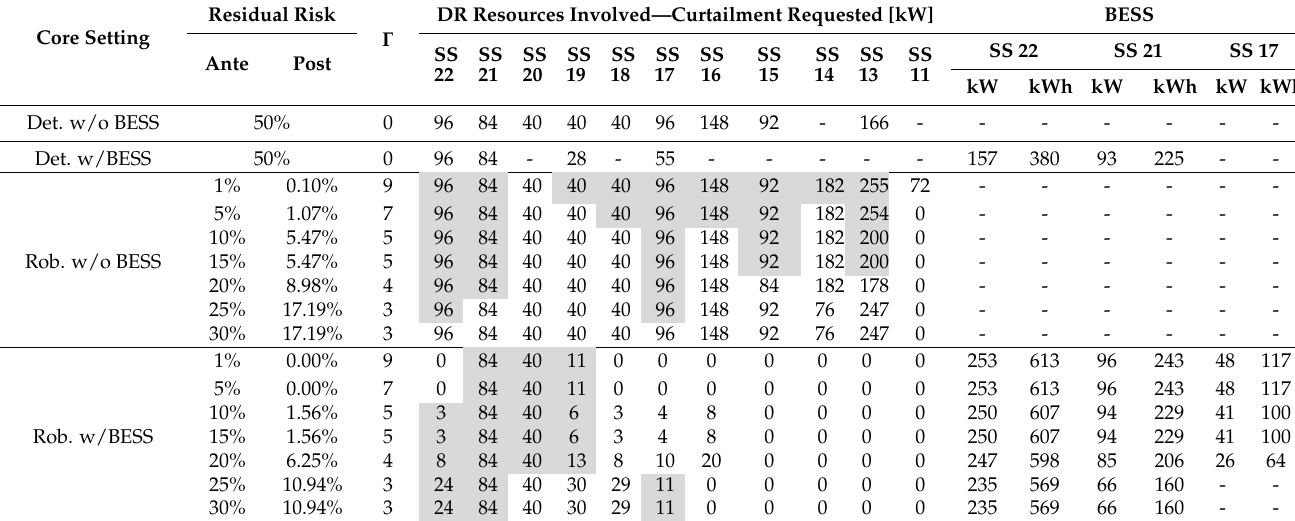
Table 5. Detailed results of the four core-settings for the single hour contingency (19th). The values of Γ are calculated for the technical constraints of feeder F2 (|J n | = 15).